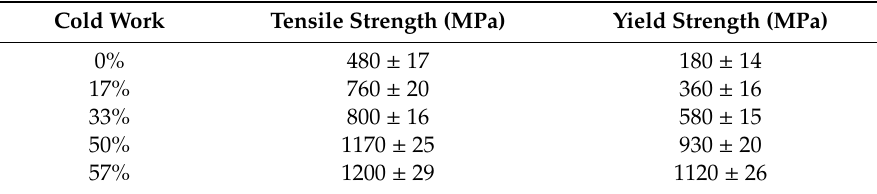
Table 3. Resistance characteristics obtained from tensile tests.